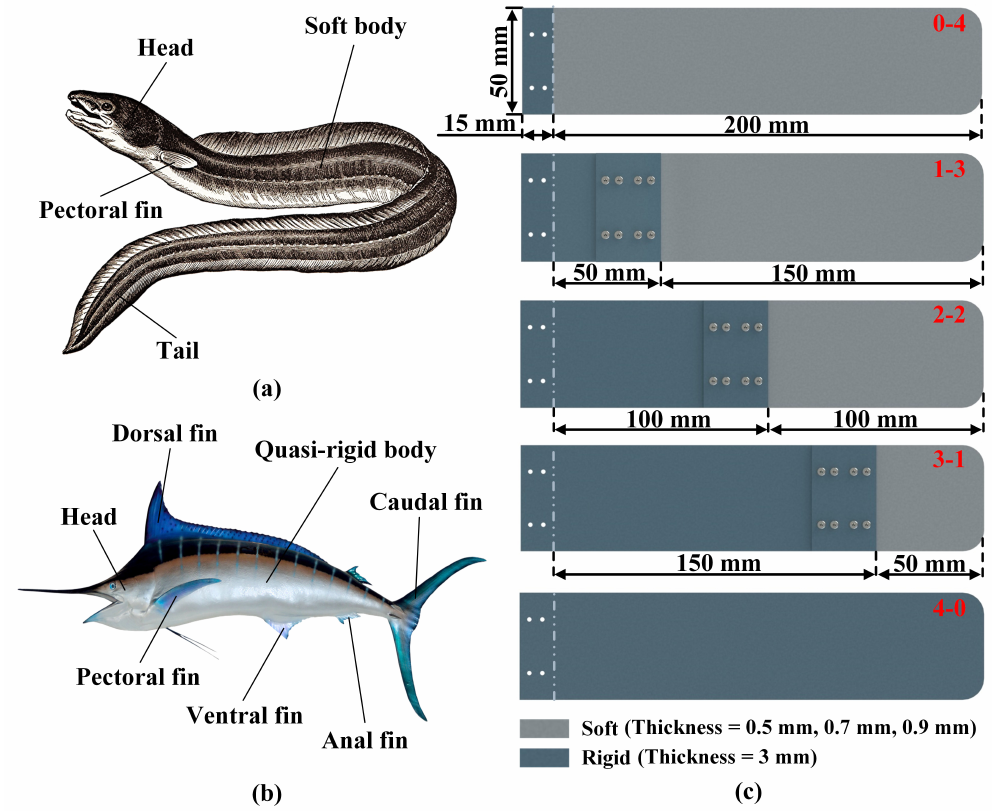
Figure 1. Biomimetic structural and mechanism models: ( a ) The eel with a flexible body. ( b ) The swordfish with a quasi-rigid body, whose swimming speed can reach 130 km/h. ( c ) The mechanism models: There are five kinds of non-uniform stiffness models. The light gray color represents the flexible material and the dark gray color represents the rigid material, and the thickness of the flexible material is 0.5 mm, 0.7 mm, and 0.9 mm, and the thickness of the rigid material is 3